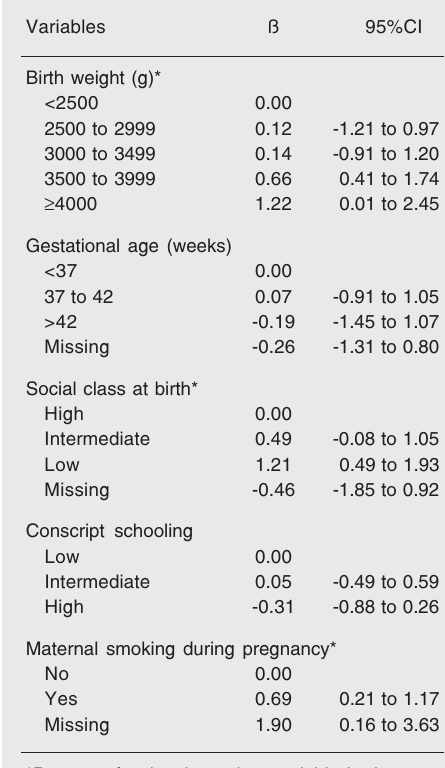
Table 2. Multiple linear regression of body mass index adjusted for social class, gestational age, social class at birth, conscript schooling, and ma- ternal smoking during pregnancy (Ribeirão Preto birth cohort study 1978/79) (N = 1189 adolescent